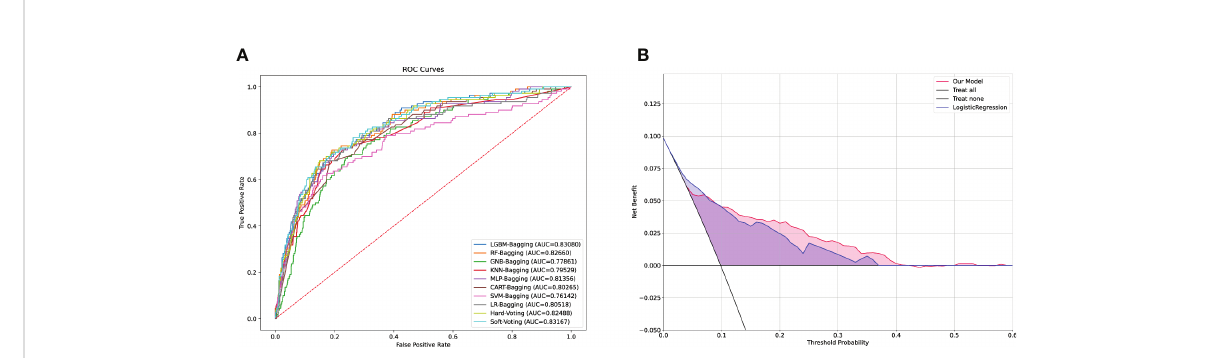
FIGURE 3 Comparison of the performance among machine learning models and DCA analysis. (A) ROC curves of the machine learning in the validation cohort. (B) Logistic DCA analysis for two models in the validation cohort. Blue shading (LR model) represents the traditional model only based on logistic regression algorithm, and red shading (stacking model) means the machine model based on ensemble learning strategies and machine learning fusion algorithms in our study. ROC, receiver operating characteristic; DCA, decision curve analysis; AUC, area under curve; LR, logistic regression.